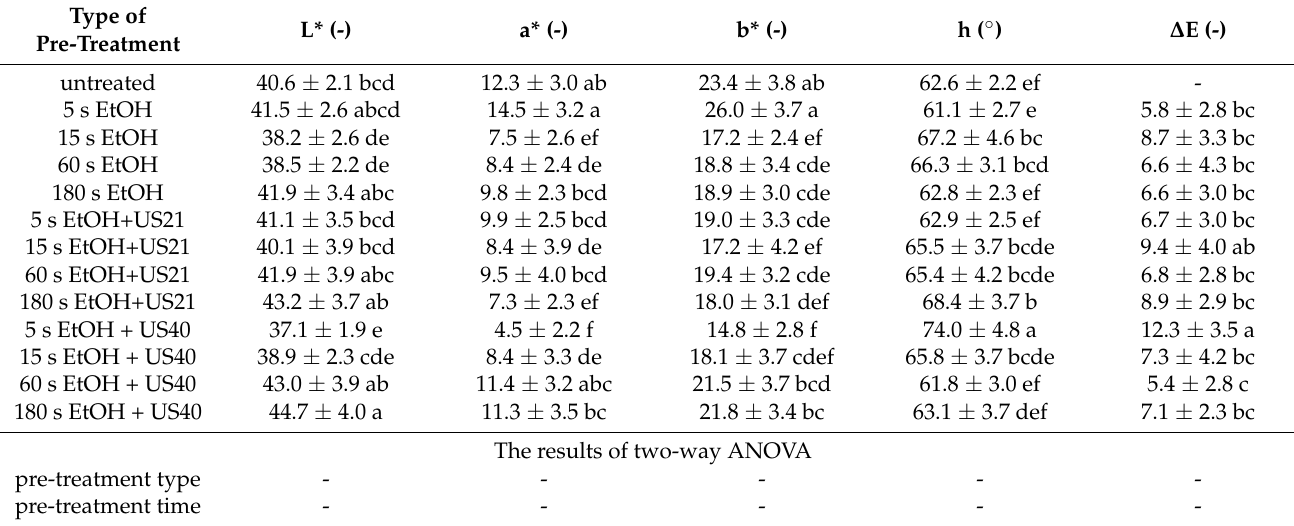
Table 2. Colour parameters (L*, a*, b*), hue angle (h ◦ ) and total colour difference ( ∆ E, in comparison to raw material) of carrot tissue pre-treated without and with ultrasound; error bars indicate ± SD (standard deviation calculated from at least 10